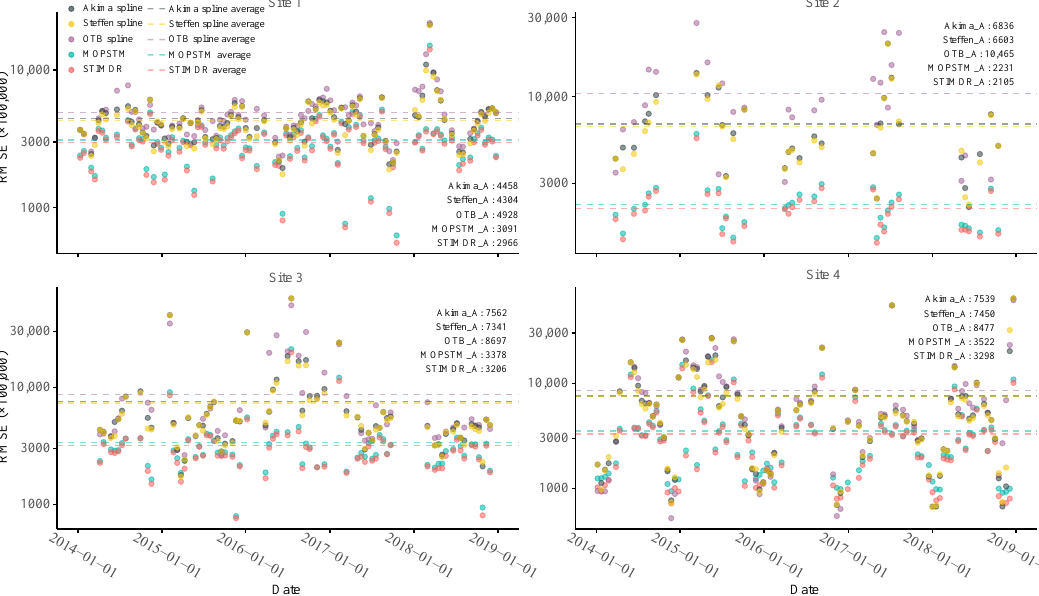
Figure 12. Accuracy of time-series experiments using Akima spline, Steffen spline, OTB spline, MOPSTM, and STIMDR with respect to RMSE based on 10,000 simulated gap pixels in each image in the time series for four sites. The Landsat 8 images were acquired from the beginning of 2014 until the end of 2018. Akima_A, Steffen_A, OTB_A, MOPSTM_A, and STIMDR_A stand for the average RMSE of the Akima spline, Steffen spline, OTB spline, MOPSTM, and STIMDR methods, respectively. The y-axis was scaled by the log base 10 function. RMSE was multiplied by